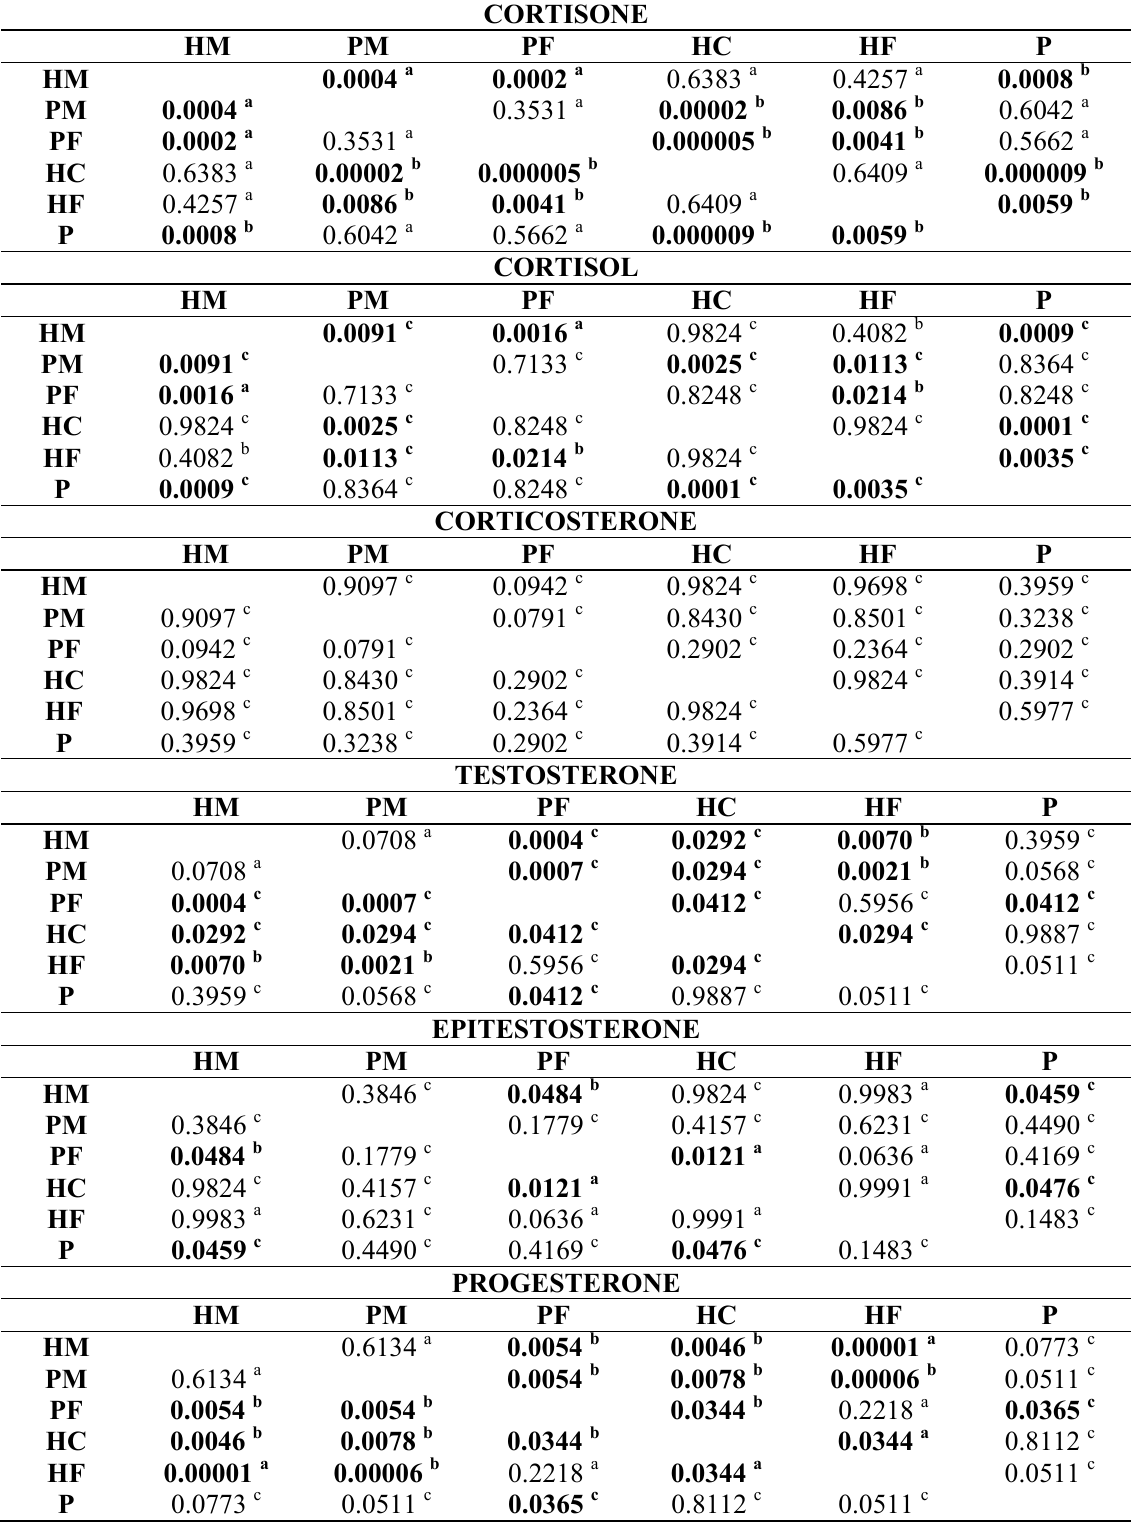
Table 4. Results of parametric and non-parametric calculations using the Student’s t -test, the separate - variances t test and the Mann-Whitney U test, respectively (statistically significant differences are indicated in